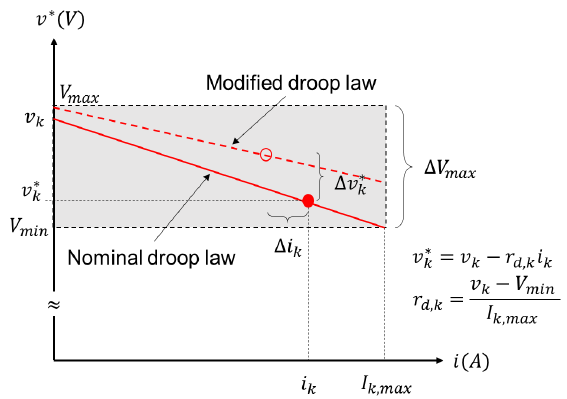
Figure 4. Modifying the droop